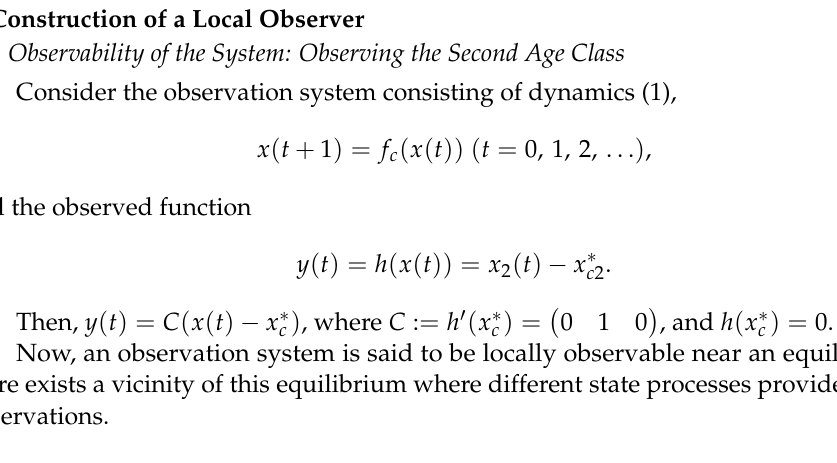
Figure 3. Trajectories running away from zero.